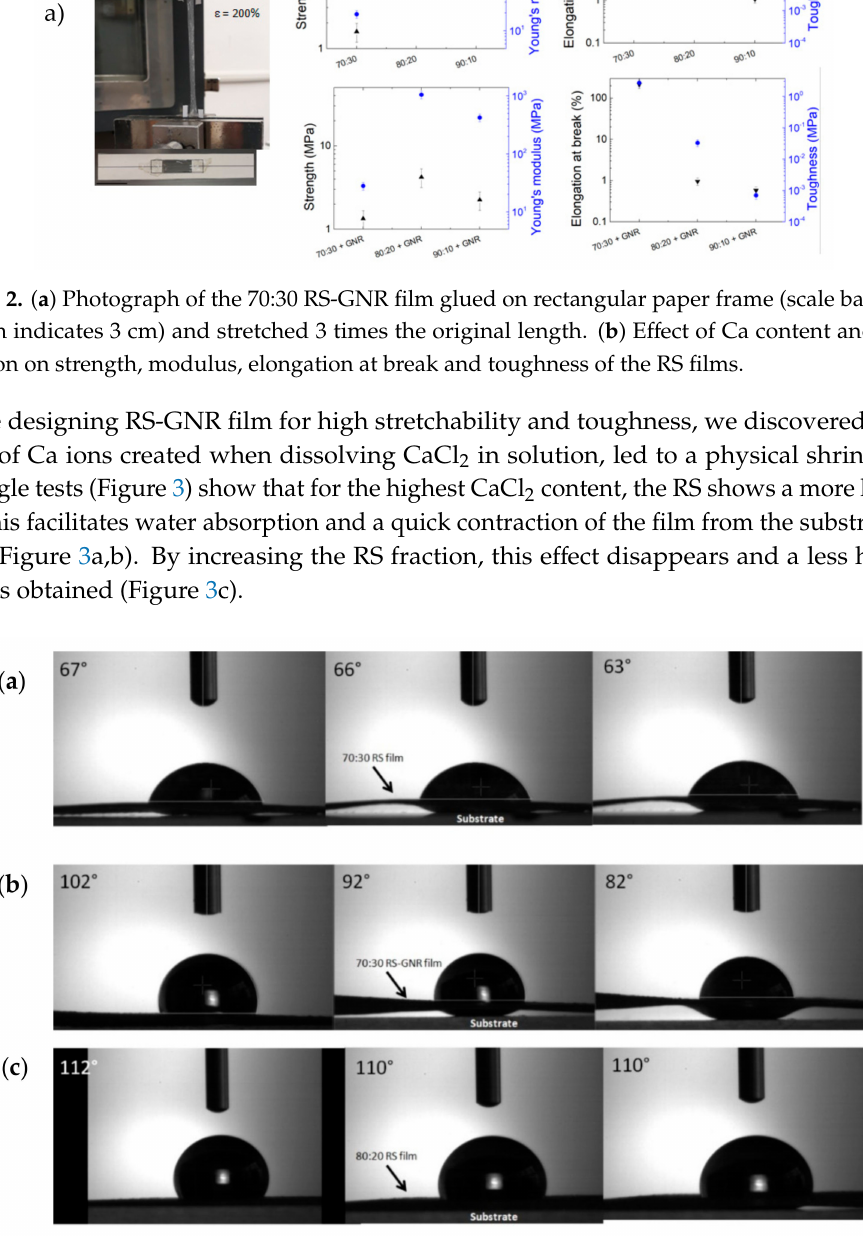
Figure 3. Snapshots of contact angle measurements of ( a ) 70:30 RS, ( b ) 70:30 RS-GNR and ( c ) 80:20 RS films, recorded (from left to right) after 5 s, 10 s and 25 s, respectively. The arrows indicate the contraction of the film moving from the substrate (see Supporting Information, Videos S1, S2 and